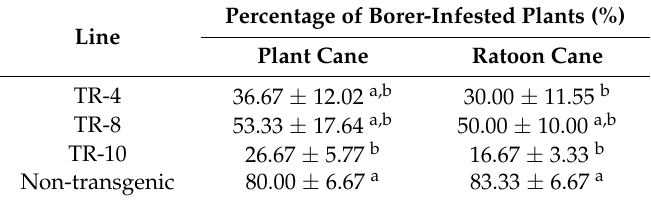
Table 3. The percentage of borer-infested plants of different cry2A transgenic sugarcane lines in plant and ratoon cane.